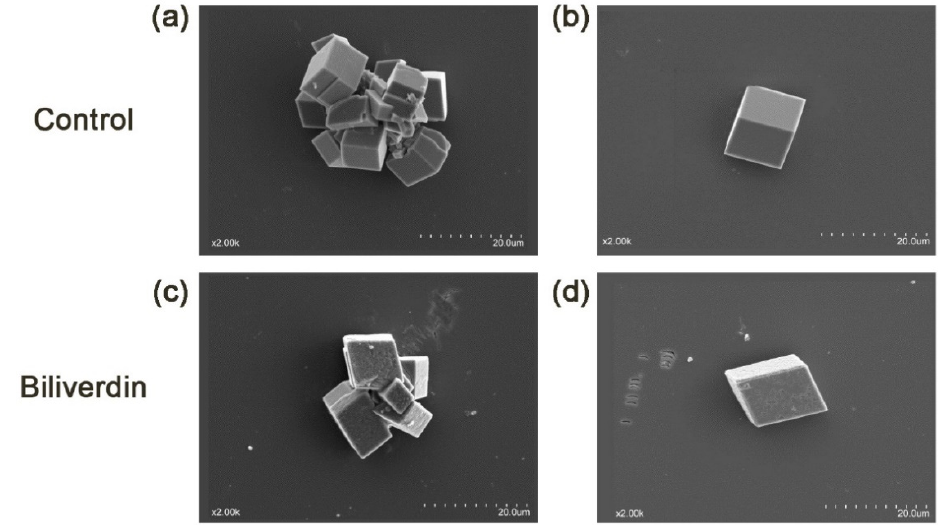
Figure 5. Scanning electron microscopic view of calcite crystals grown in the absence or presence ( a , b , control) of biliverdin ( c , d ). ( a , c ) View of aggregated crystals of the blank and biliverdin-treated groups, respectively. ( b , d ) View of single-separated crystals of the blank and biliverdin-treated groups, respectively. The scale bars are indicated at the bottom right of the pictures, and the magnification is shown at the bottom left.